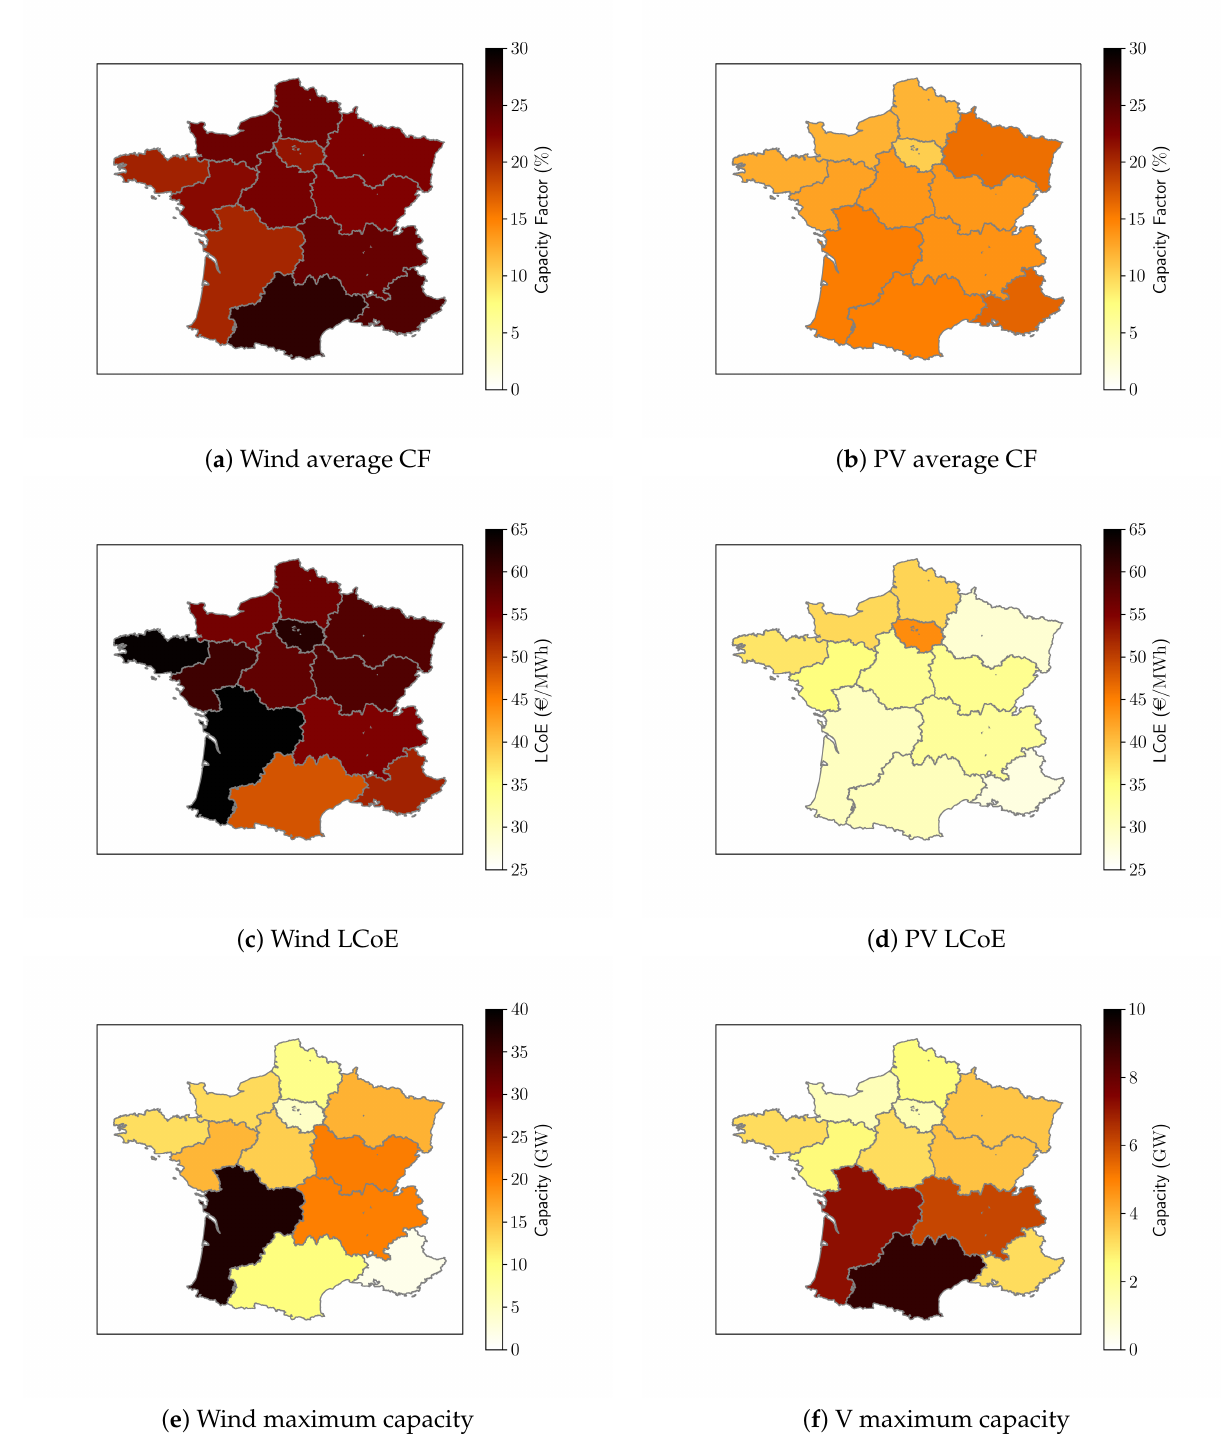
Figure 3. Regional distributions of the ( top ) average capacity factors, ( middle ) levelized costs of electricity (Equation (8)), and ( bottom ) maximum capacities, for onshore wind ( left ) and photovoltaic ( right